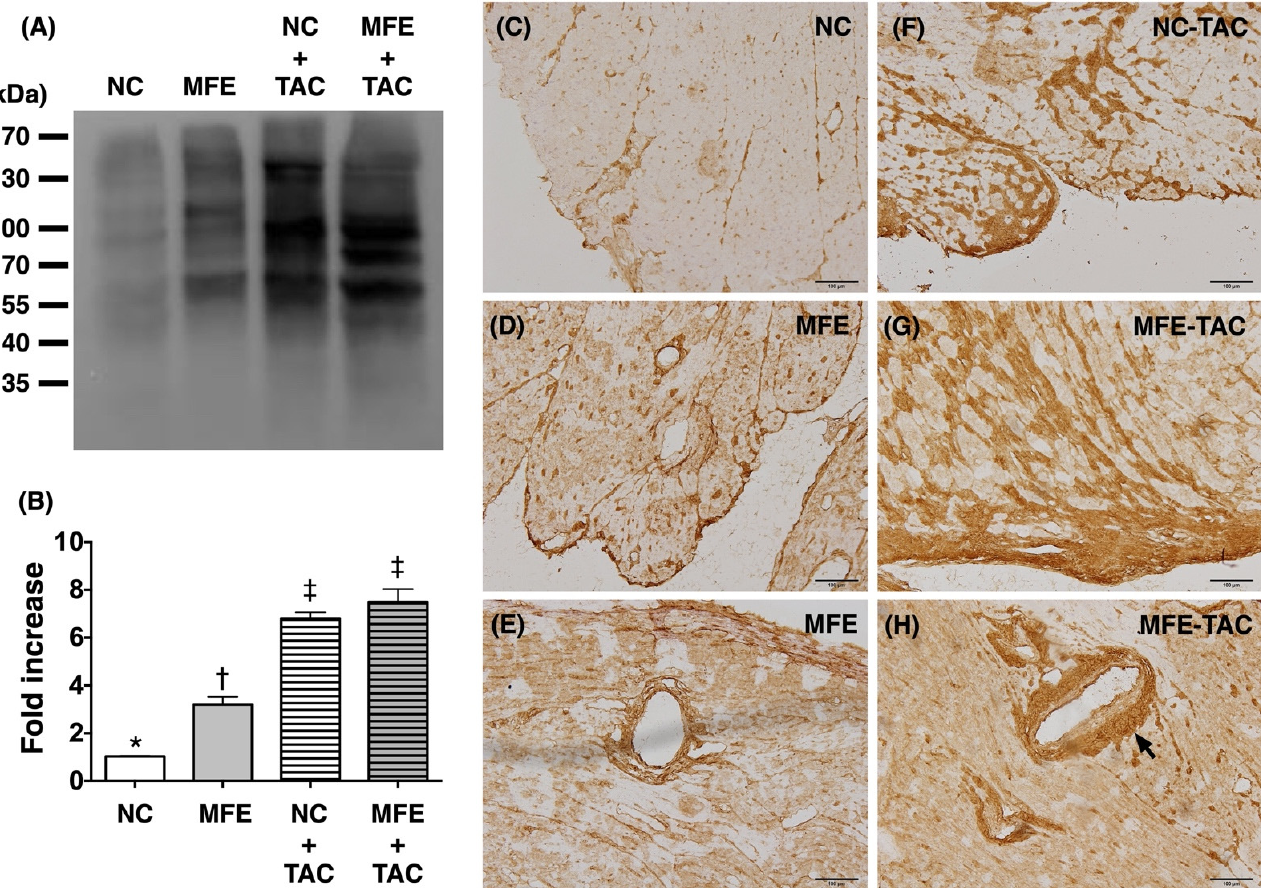
Figure 4. Elevated myocardial oxidative stress in offspring with maternal fructose exposure (MFE) and ventricular pressure overload induced by transverse aortic constriction (TAC). ( A ) OxyBlot showing expression levels of myocardial oxidized proteins as fold increase relative to NC group. ( B ) Comparison of myocardial oxidized protein expressions among different treatment groups. ( C – H ) OxyIHC demonstrating the distribution of myocardial oxidized proteins. Black arrow indicates significant accumulations of oxidized proteins in myocardial muscularized arteries of offspring with MFE and TAC. NC, normal control. Groups with different symbols (*, †, ‡), p < 0.05. n = 8 for each group. Scale bar in left lower corner indicates 100 µm .